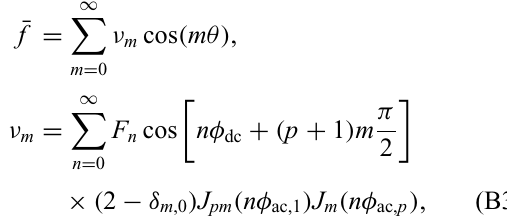
FIG. 11. An example amplitude transfer function of a flux transmission line, for qubit 5 in this case (ref. Table I). At each frequency, the effective modulation amplitude seen by the qubit is determined by measuring the detuning of the qubit frequency. The strong frequency dependence of the transfer function can then be compensated for by scaling flux pulses according to their frequency and its measured relative transmission. Fig. 11. In the construction of bichromatic pulses, the amplitude of each tone must be scaled appropriately for its frequency before the tones are digitally added together.